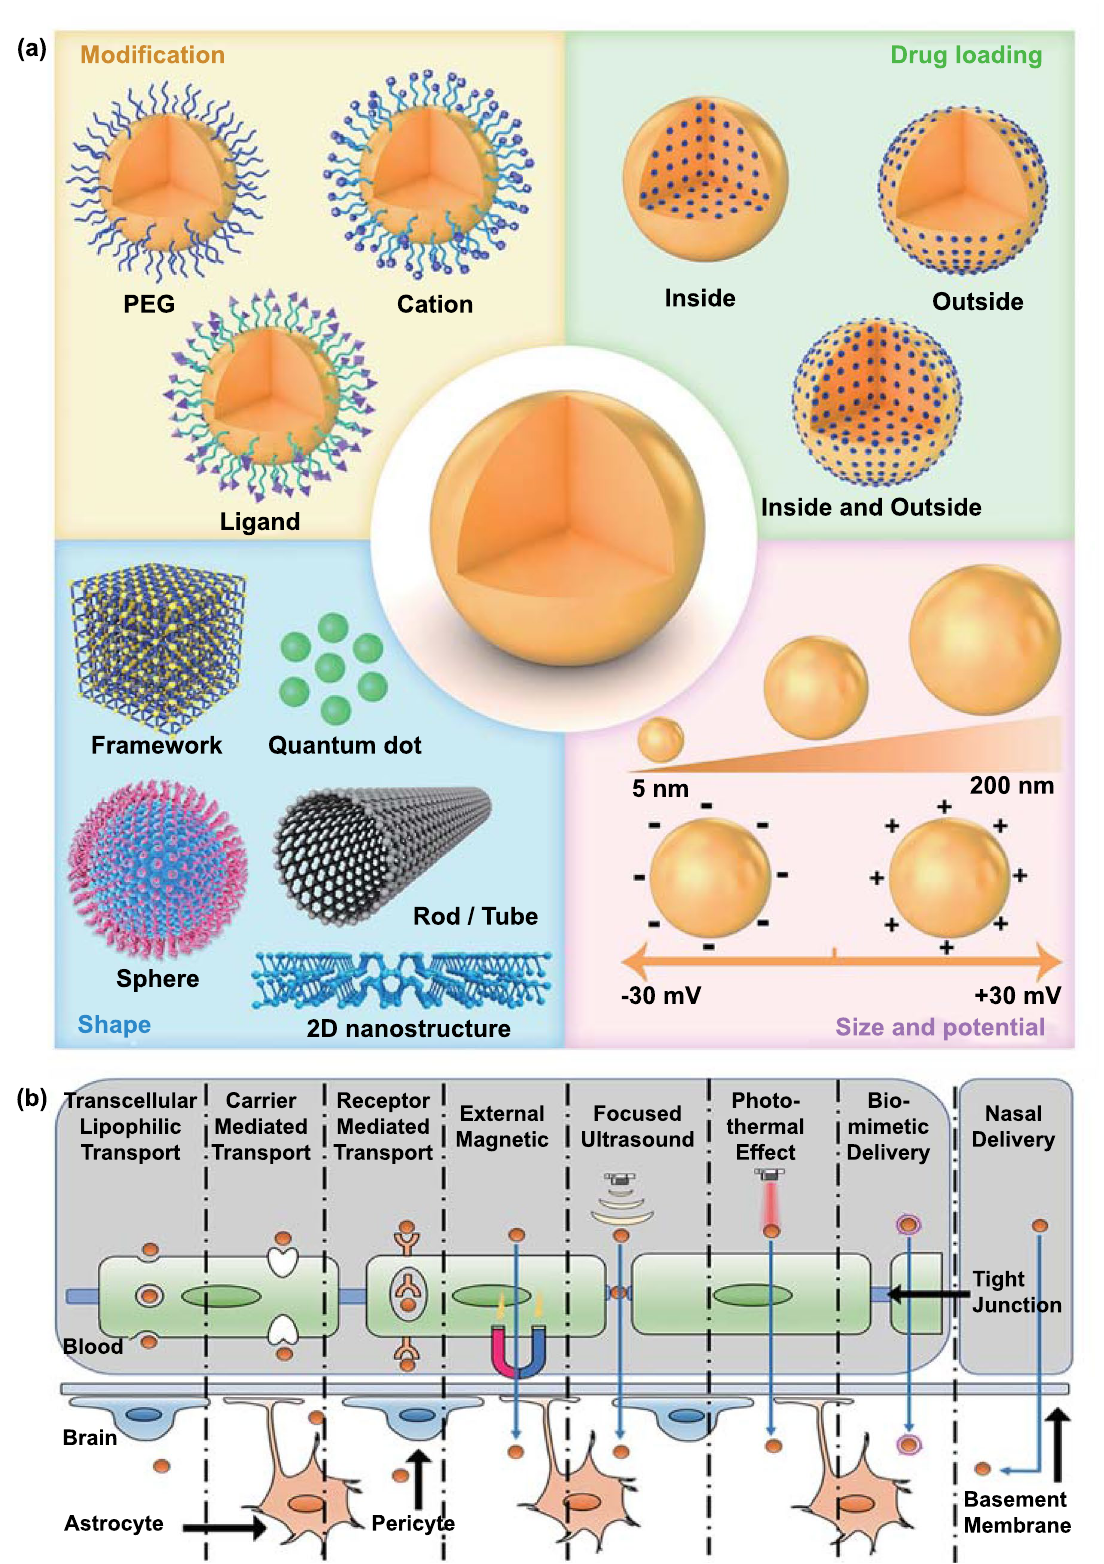
Fig. 2 Design strategies for nanoplatforms that can cross the BBB ( a) , and transport pathways used in PD treatment (